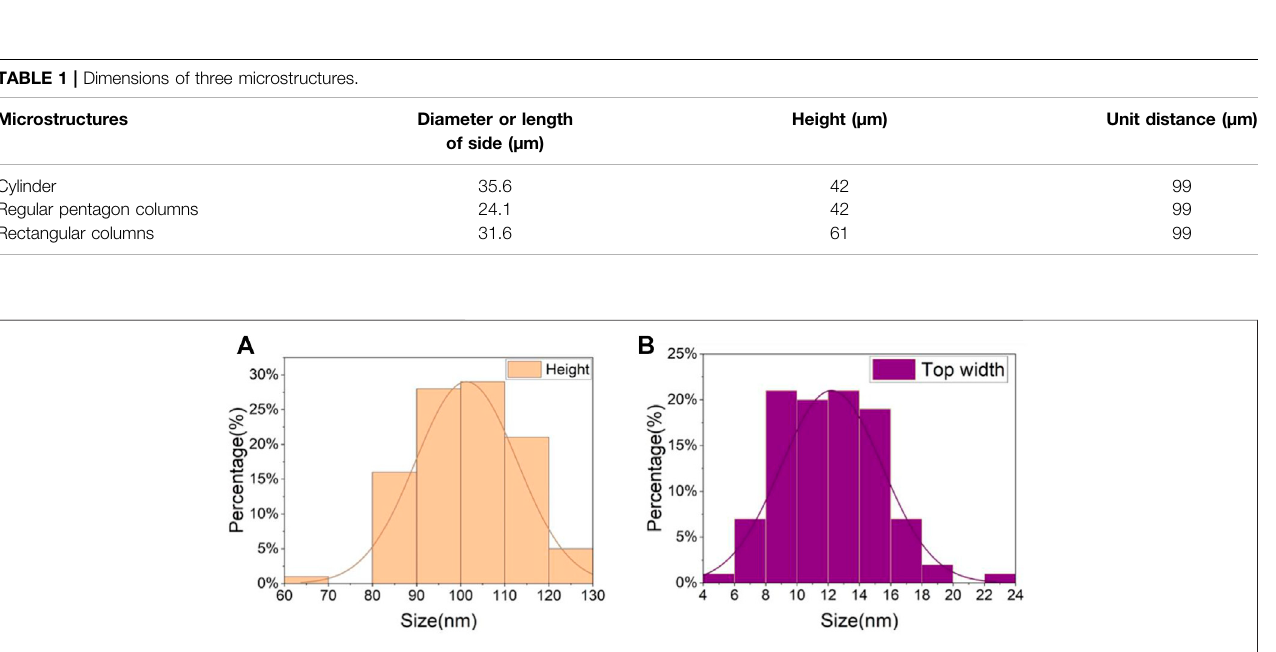
FIGURE 5 | The measured statistic data of the nickel nanowire sizes. (A) height of nanowires, (B) top width of nickel nanowires.